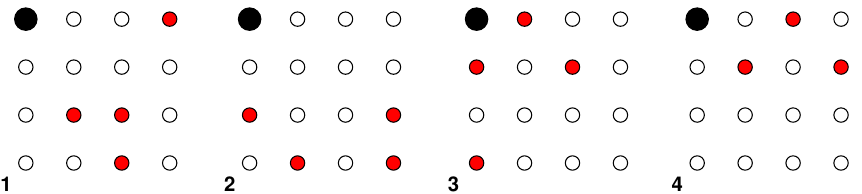
Figure 3. Example scenario for the network of 16 nodes and four frames. Nodes having data to send are marked in red, base station is in a larger black one. Note that every node except the base station can send its data in one of the